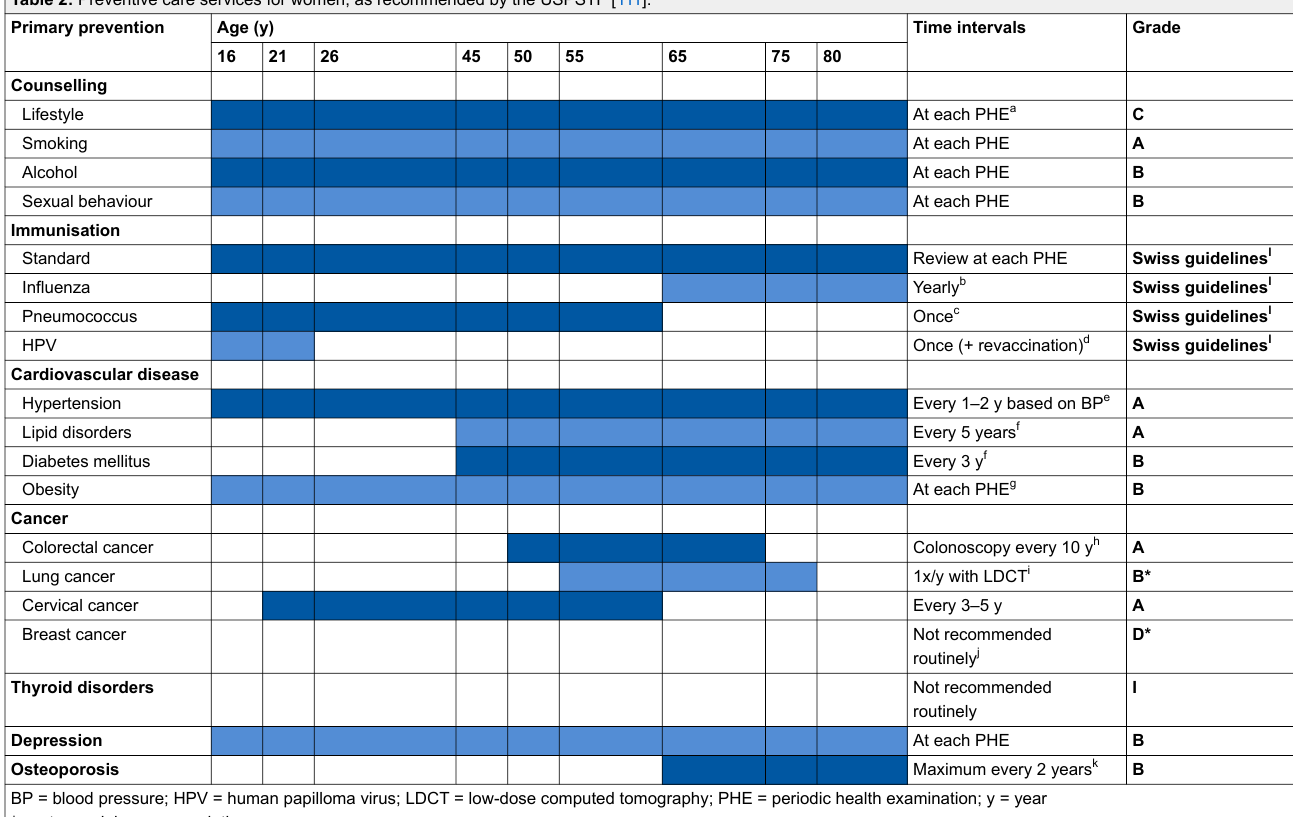
Table 2: Preventive care services for women, as recommended by the USPSTF